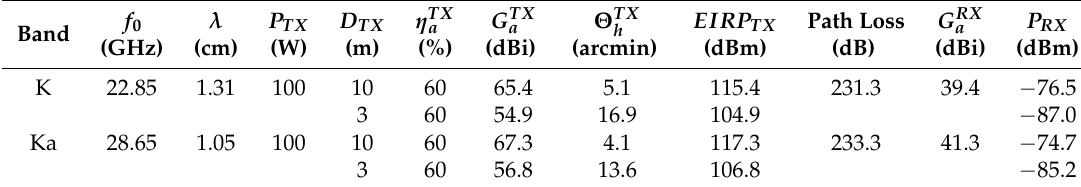
Table 2. Transmitter EIRP and Received Power in the K/Ka-Bands versus D TX